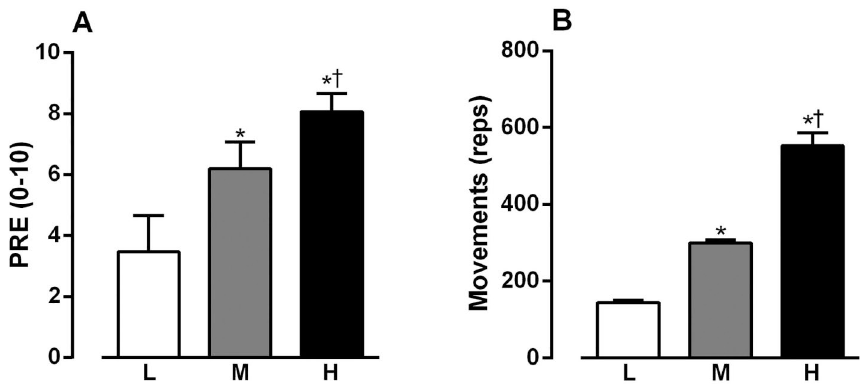
Figure 5 - Values expressed as mean ± standard deviation of carrying out the protocols of low (L), moderate (M), and high (H) cadences of the rate of perceived exertion of the session (Panel A) and total movements (Panel B). *p < 0.01 vs. L. † p < 0.01